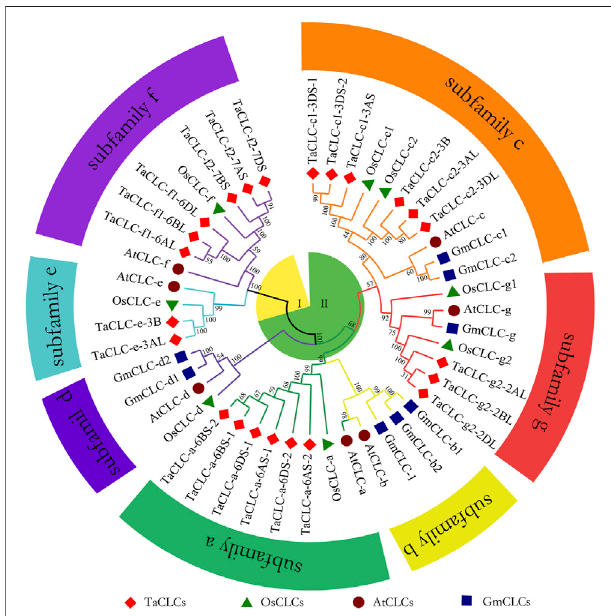
FIGURE 1 | The phylogenetic tree of the CLC family of wheat, rice, soybean and Arabidopsis. The proteins belonging to each of four species are represented by different shapes and colors. The TaCLC family proteins were divided into seven subfamilies (-a, -b, -c, -d, -e, -f, and -g) and two subclasses (I and II), which are indicated with different shapes and colors of lines.TheCLCproteinslociofwheat,rice,soybean,andArabidopsisarelisted in Supplementary Table S1 . Ta, Triticum aestivum ; Os, Oryza sativa ; Gm, Glycine max ; At, Arabidopsis thaliana